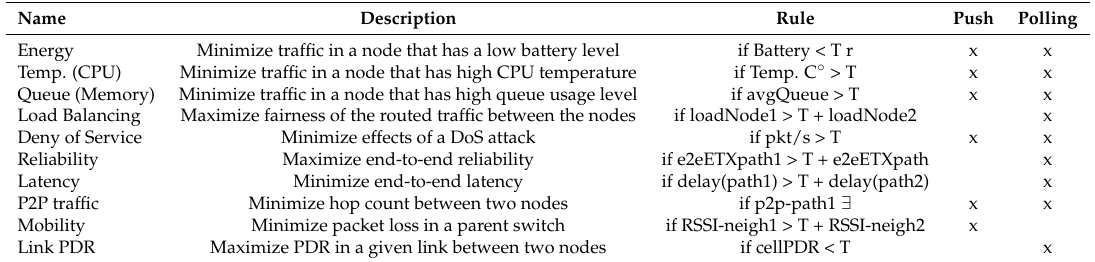
Table 2. Table with example of policies that can be applied. T means